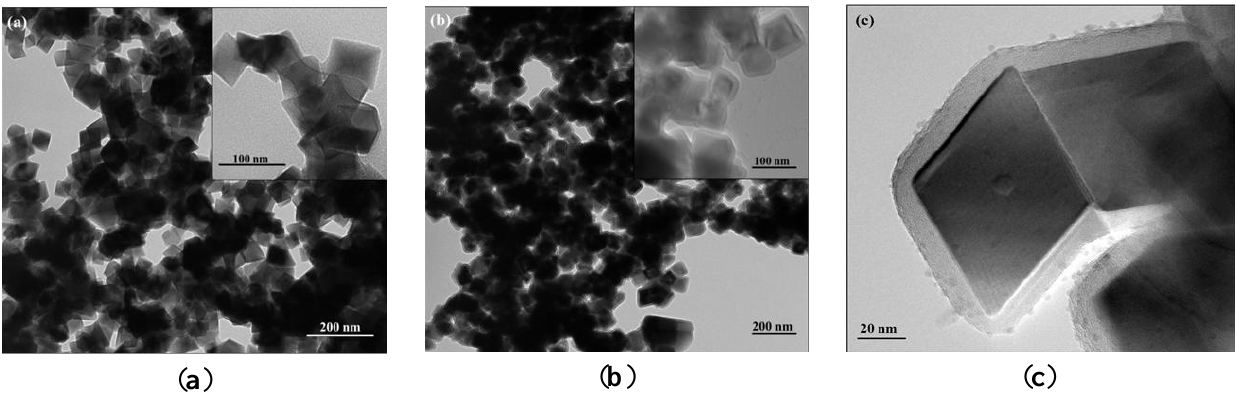
Figure 4. ATR-FTIR spectra of magnetite nanoparticles (Fe magnetite nanoparticles (Fe